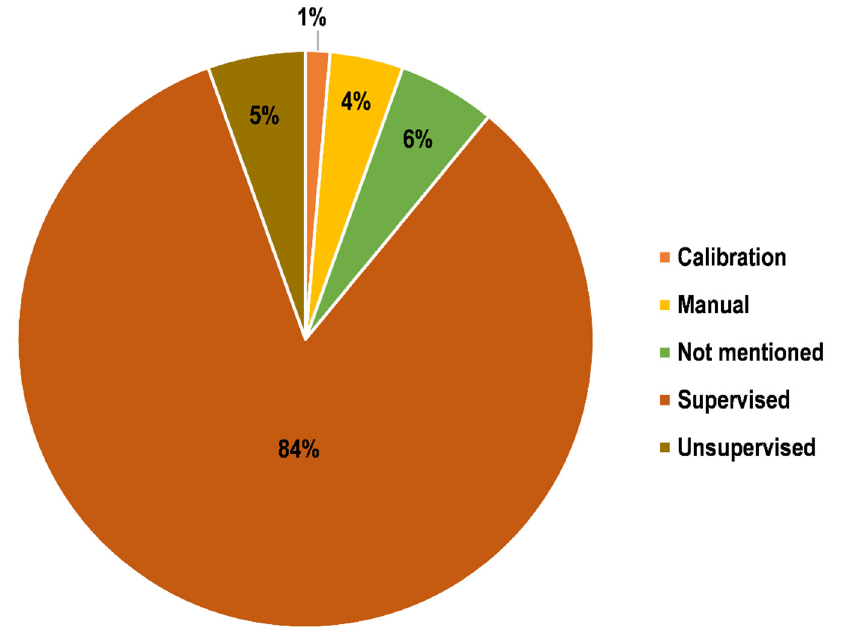
Figure 3. Percentage of each methodology used for image classification for the 73 reviewed studies.